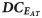
Estimation performance of OBEM on-line updating method (example of DCEAT).